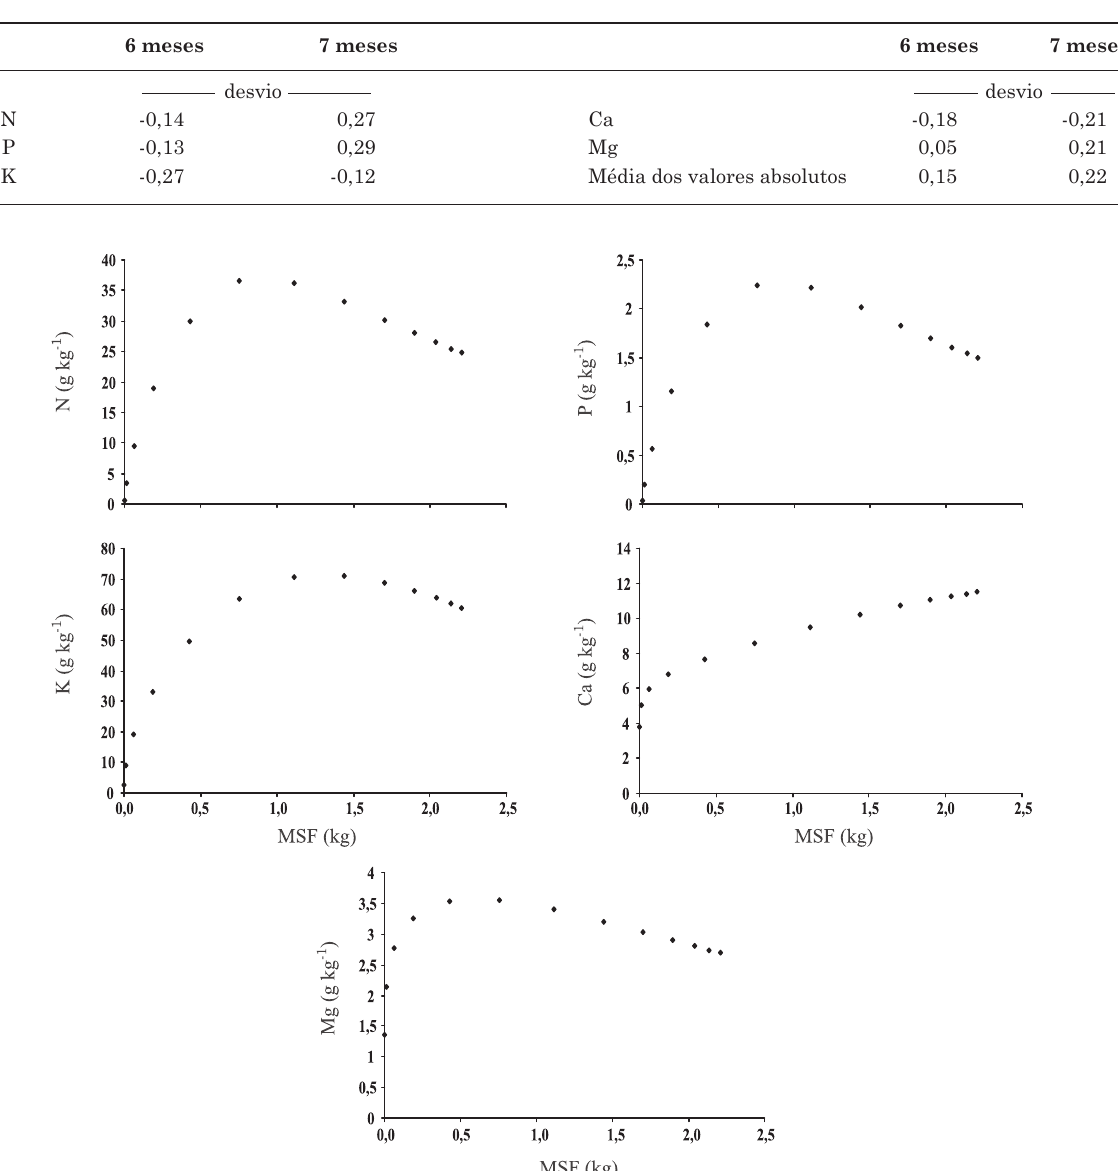
Quadro 3. Valores dos desvios entre os valores de TCr mS /Tar Q para n, p, K, ca e mg em relação a 1